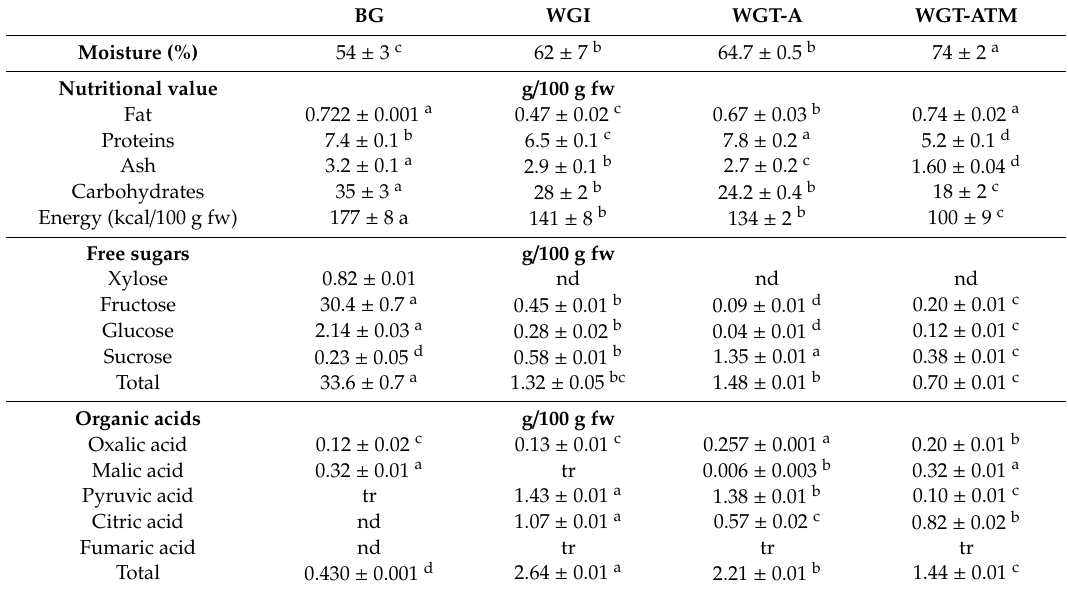
Table 1. Nutritional value and hydrophilic compounds of A. sativum samples (mean ± SD). BG WGI WGT-A